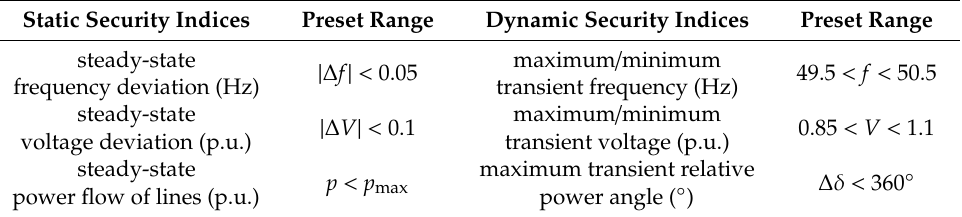
Table 2. Preset ranges of the security assessment index